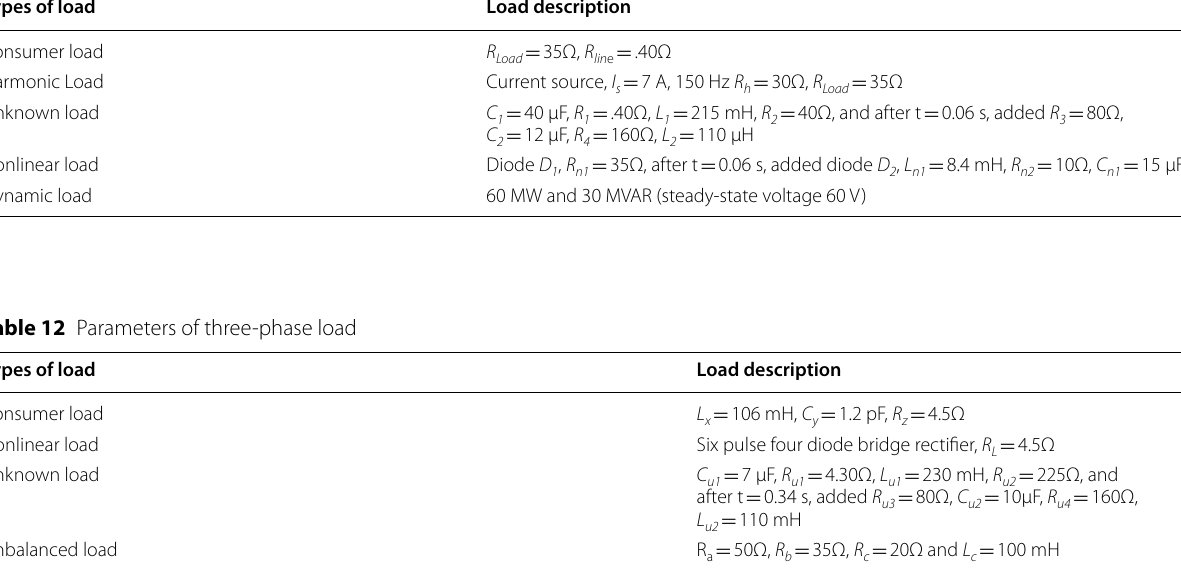
Table 11 Parameters of single‑phase load Types of load